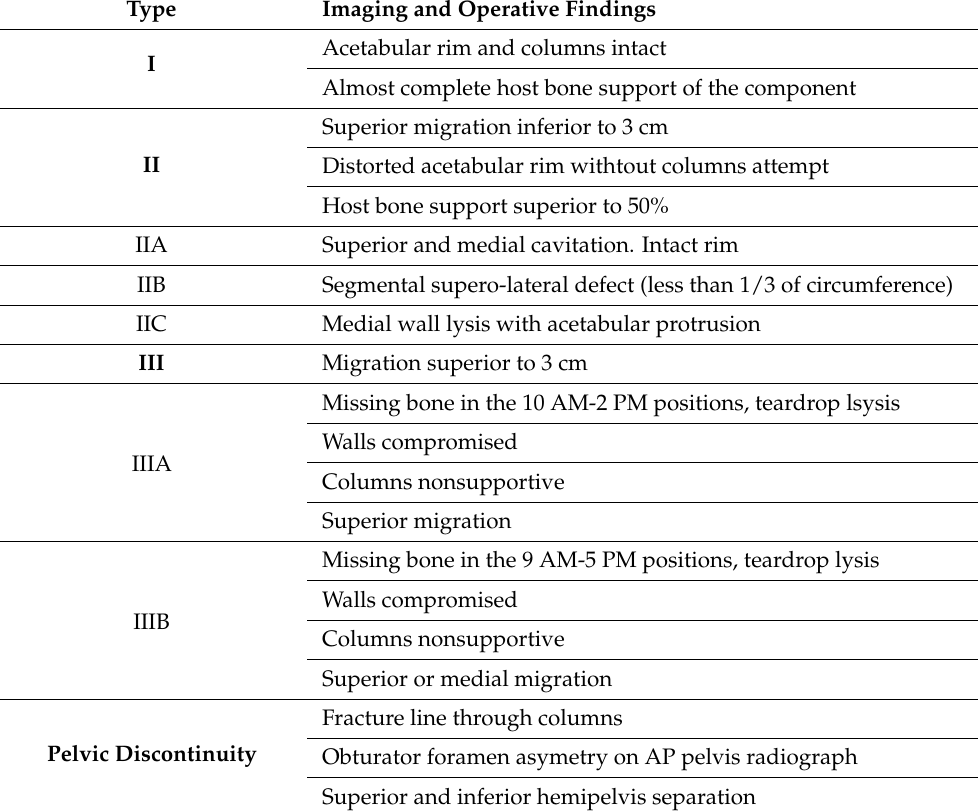
Table 3. Paprosky